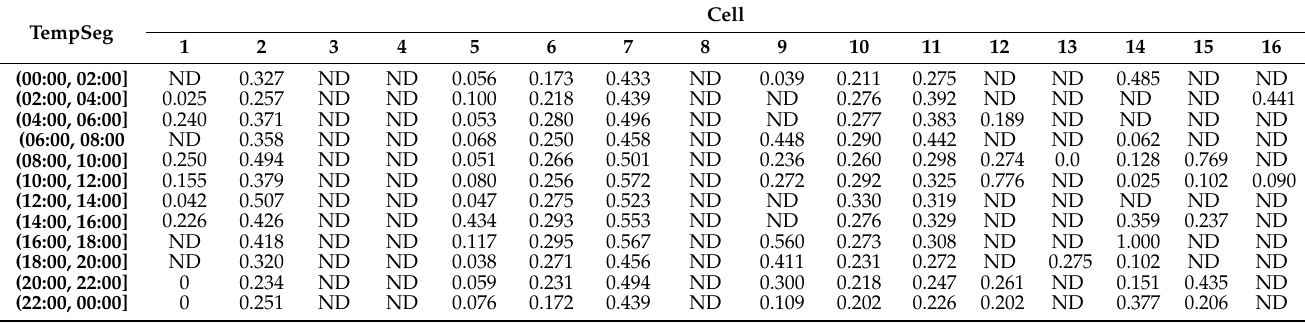
Table 3. Calculated speed limit rates for 3 August 2013 with MaxSpeed = 40